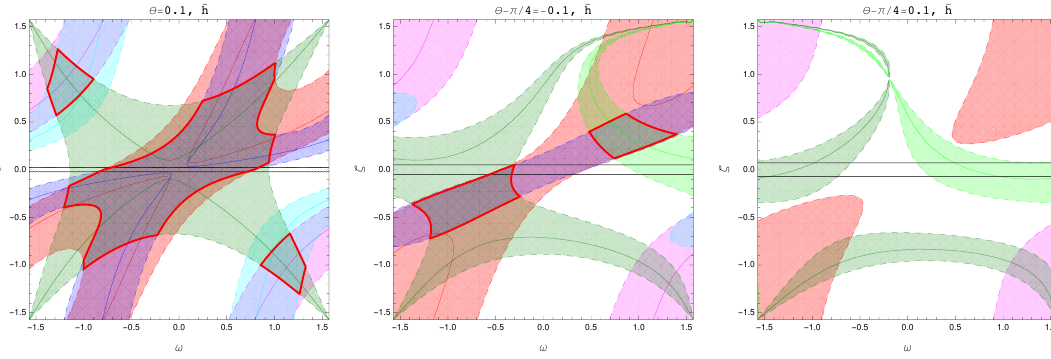
Figure 11 . Same as (cid:12)gure 10 in the plane ! - (cid:16) and for (cid:12)xed values of (cid:18) . The three panels correspond to the couplings of ~ h for (cid:18) = 0 : 1 (right), (cid:18) = (cid:25)= 4 (cid:0) 0 : 1 (middle) and (cid:18) = (cid:25)= 4 + 0 : 1